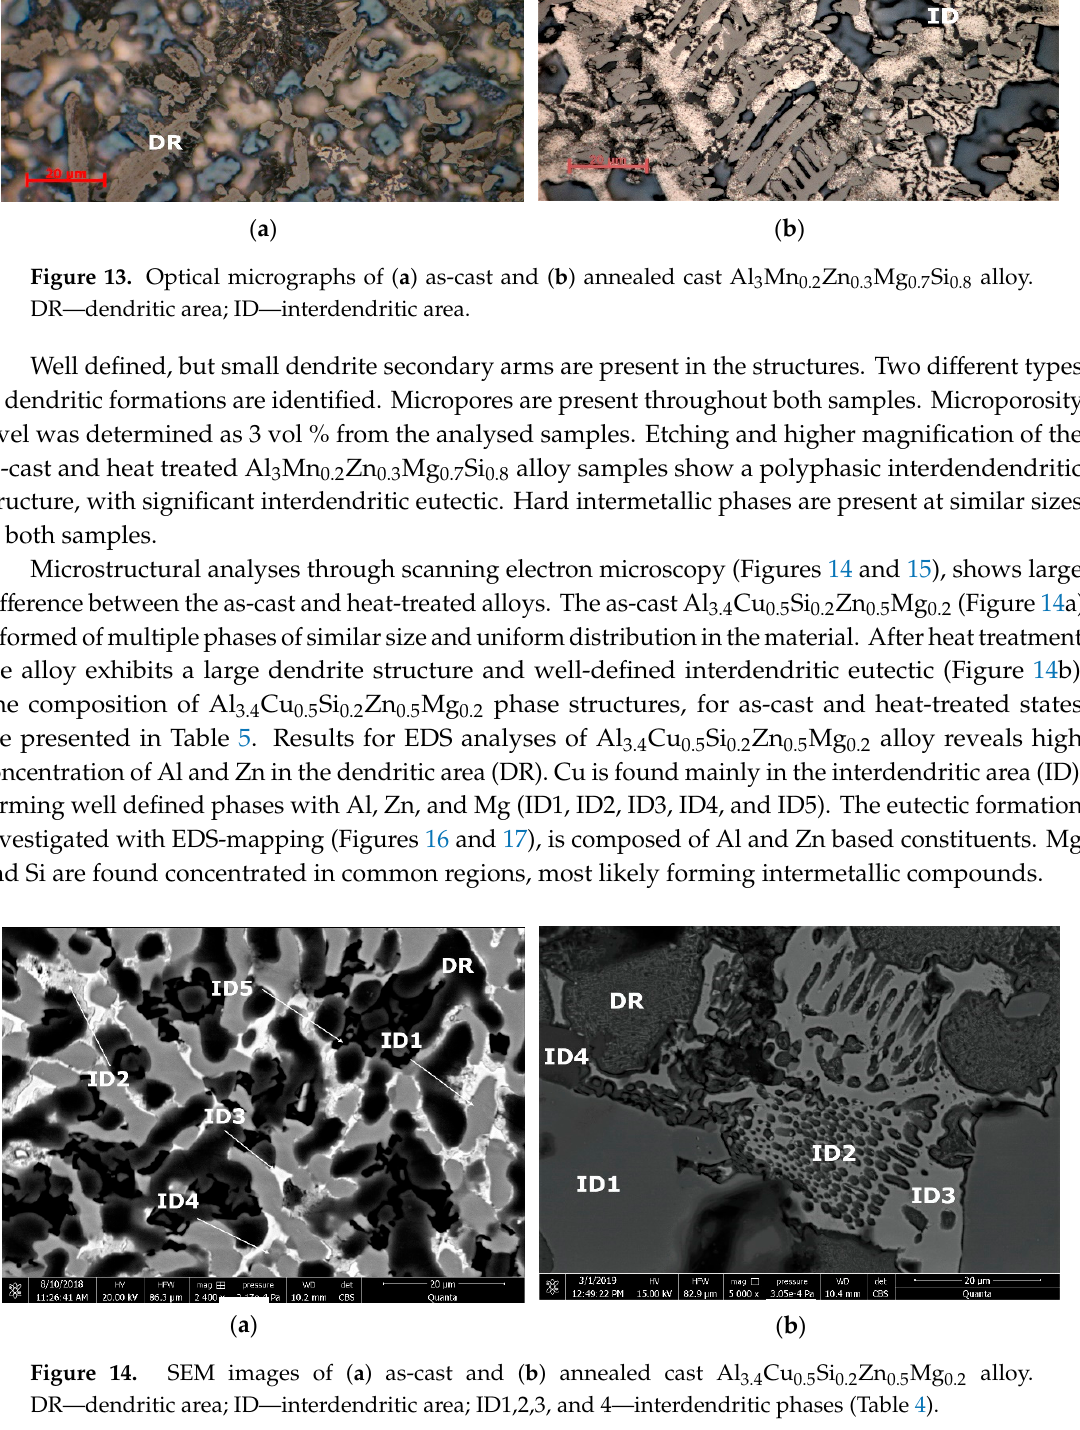
Figure 14. SEM images of ( a ) as-cast and ( b ) annealed cast Al 3.4 Cu 0.5 Si 0.2 Zn 0.5 Mg 0.2 alloy. DR—dendritic area; ID—interdendritic area; ID1,2,3, and 4—interdendritic phases (Table